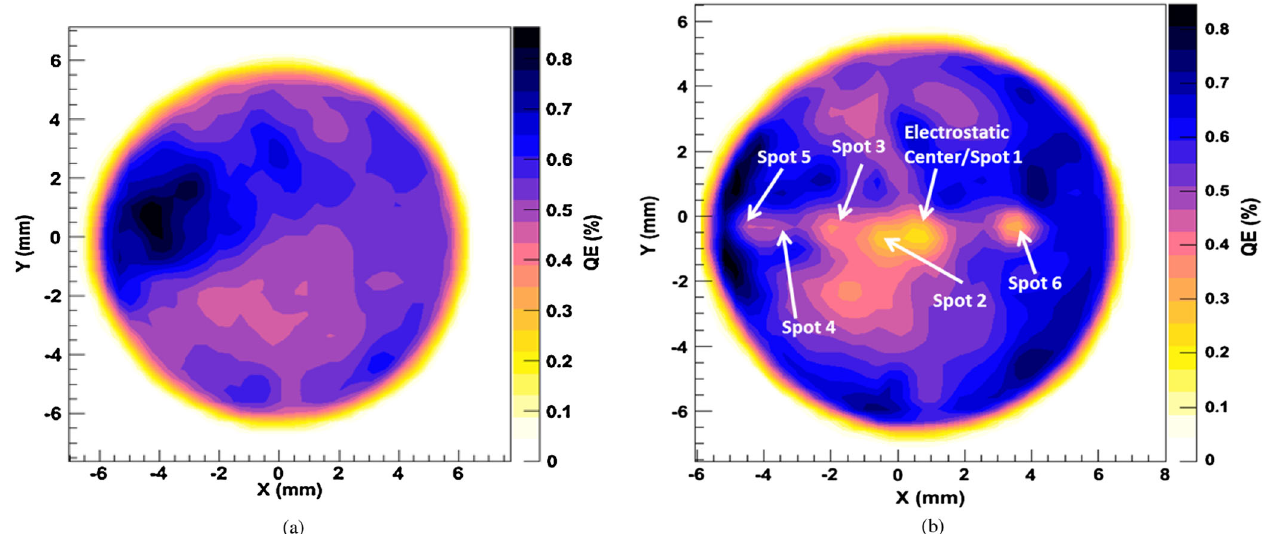
FIG. 6. QE maps of K 2 CsSb photocathode #1 using 532 nm light when the photocathode exhibited poor lifetime: (a) before running beam and (b) after running beam from many locations (the numbering denotes the sequential order of the run).